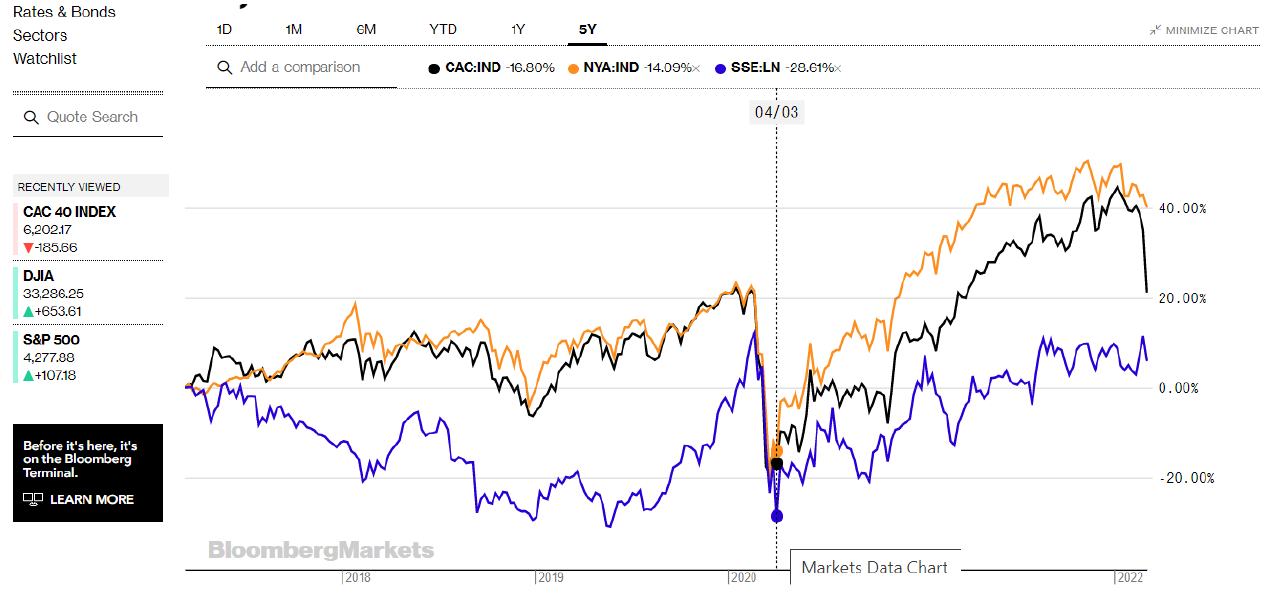
Figure 5. The evolution of the composite index for the Shanghai, Paris and New York Stock Exchanges. Source: [47–49].